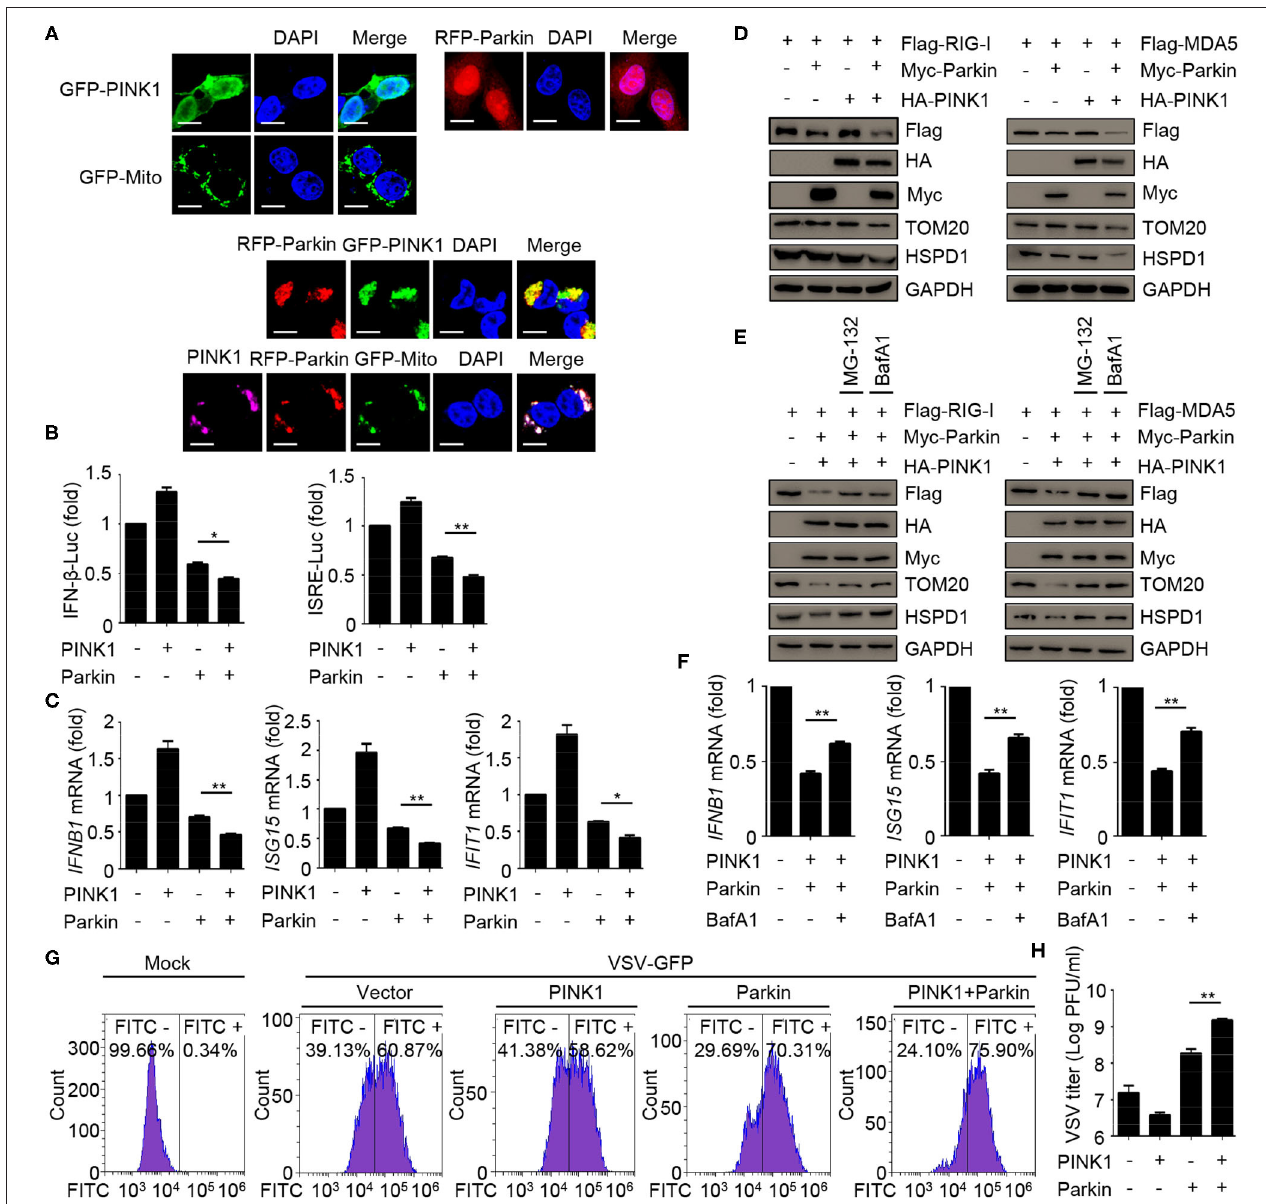
FIGURE 4 | Mitophagy mediated by PINK1/Parkin negatively regulates the type I IFN responses. (A) 293T cells were transfected with PINK1, Parkin, and GFP-Mito alone or together for 24h, and then subjected to IF assays. Scale bar is 10 µ m. (B) HEK293 cells were transfected with PINK1 or Parkin alone or together with IFN- β or ISRE luciferase reporter, 24h post-transfection, stimulated with SeV for 10h, and subjected to luciferase assays. (C) HEK293 cells were transfected with PINK1 or Parkin alone or together, 24h post-transfection, stimulated with SeV for 10h, and subjected to quantitative RT-PCR analysis. (D) Flag-RIG-I or Flag-MDA5 were co-transfected with HA-PINK1 or Myc-Parkin in 293T cells for 24h, and the whole cell extracts were subjected to IB analysis. (E) Flag-RIG-I or Flag-MDA5 were co-transfected with vector or HA-PINK1 and Myc-Parkin in 293T cells for 24h, and untreated or treated with MG-132 (10 µ M) or BafA1 (200nM) for 8h. The whole cell extracts were subjected to IB analysis. (F) HEK293 cells were transfected with vector or PINK1 and Parkin, 24h post-transfection, stimulated with SeV for 10h in the absence or presence of BafA1 (200nM), and subjected to quantitative RT-PCR analysis. (G) HEK293 cells were transfected with PINK1 and Parkin alone or together for 24h, then cells were infected with VSV-GFP (MOI = 0.01), and then cells were subjected to flow cytometer assays. (H) HEK293 cells were transfected with PINK1 and Parkin alone or together for 24h, then cells were infected with VSV-GFP (MOI = 0.01), and the supernatants were subjected to VSV plaque assays. The data represent the average of three independent experiments and were analyzed by unpaired t- test. All data represent the mean ± S.D. * p < 0.05, and ** p < 0.01.